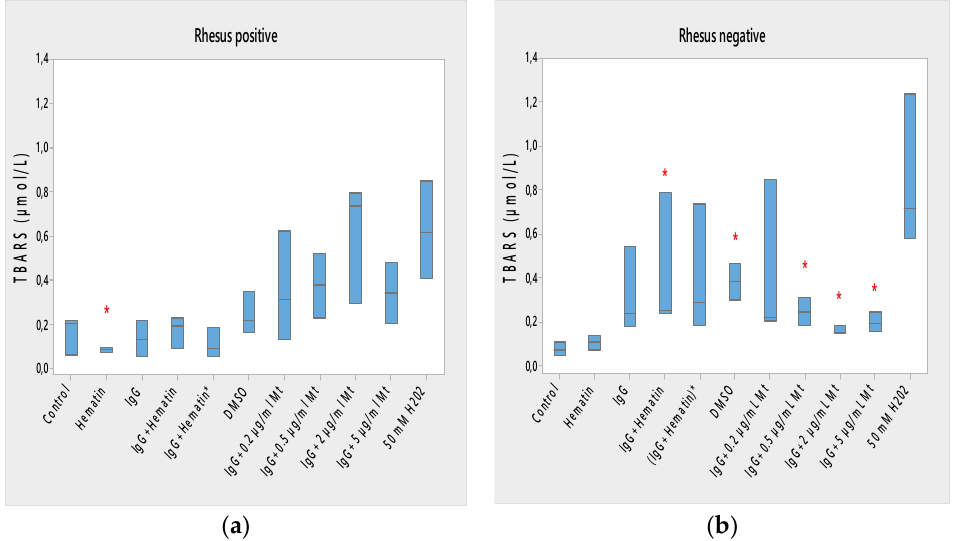
Figure 5. Lipid peroxidation in erythrocytes ( a ) with the Rh-positive and ( b ) Rh-negative factor as a function of fixed concentrations of pooled immunoglobulin G (10 mg/mL), hematin (80 µM) and melittin (0.2 µg/mL Mt; 0.5 µg/mL Mt; 2 µg/mL Mt and 5 µg/mL Mt); erythrocytes were treated with biomacromolecules for 1 h at 37 °C. The pre-incubated sample of pooled immunoglobulin G (10 mg/mL) with hematin (80 µM) is indicated by an asterisk on the abscissa. Lipid peroxidation measurements were performed at 37 °C in phosphate buffered saline (PBS, 2 mM NaN 3 ), pH 7.4. Each value is the mean ± SD of three independent preparations. * p < 0.05 compared to the untreated control (red asterisks). There were no identified changes in sample values compared to those of the DMSO-treated control (green asterisks). Second control samples contained DMSO (80 µM). The positive control of 50 mM H 2 O 2 represents the maximal value of TBARS products (incubation of erythrocytes in the presence of 50 mM H 2 O 2 for 1 h at 37 °C).